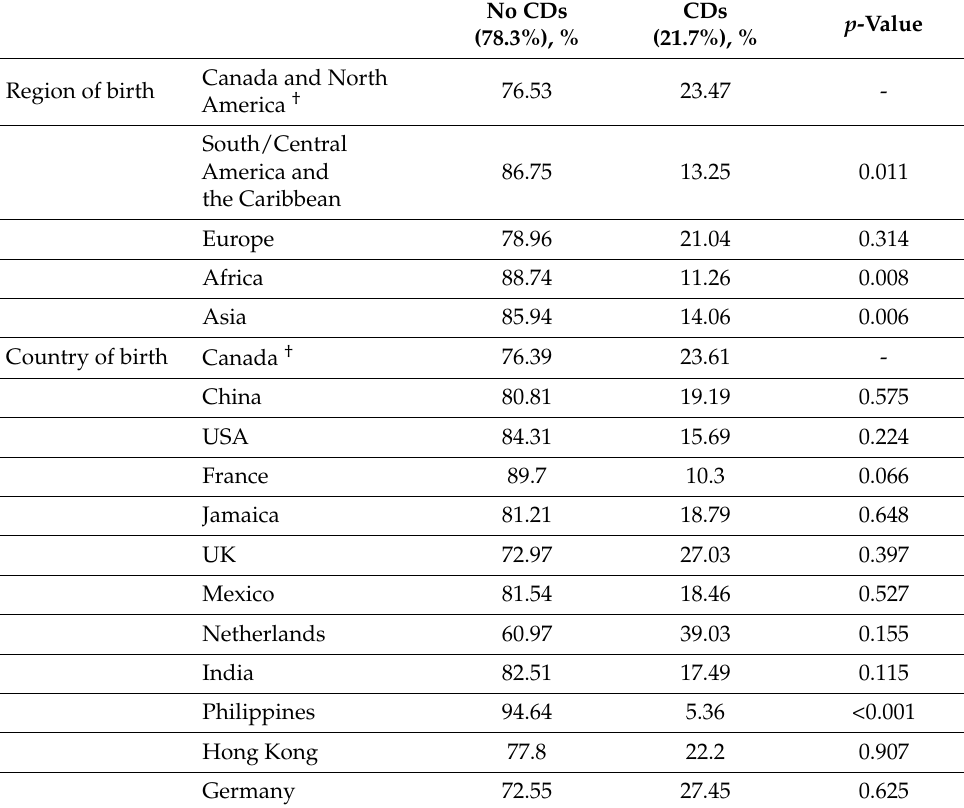
Table A3. Weighted prevalence of chronic diseases by country and region of